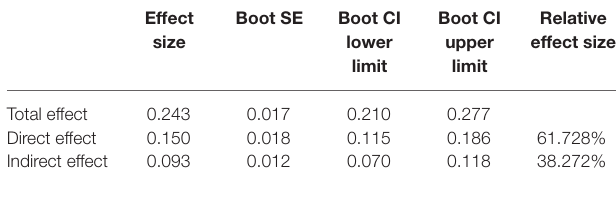
TABLE 2 | Testing the mediating effect of PTG on creativity. Predictors On GSE On creativity